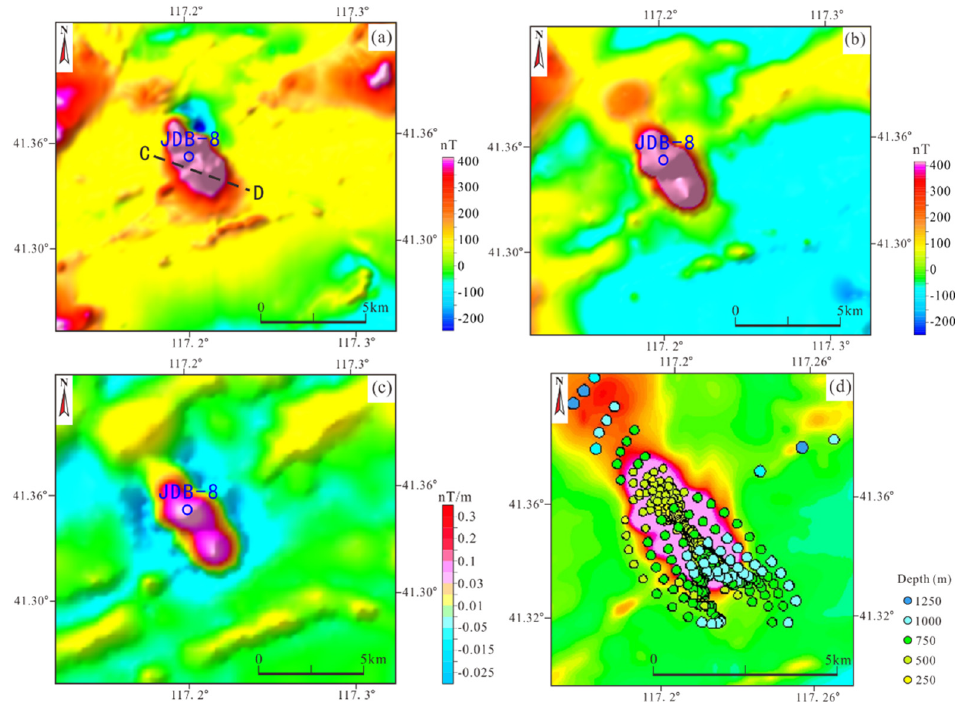
Figure 10. Aeromagnetic anomaly JDB-8 and its conversion: ( a ) Aeromagnetic data ∆ T, ( b ) reduction to the pole of aeromagnetic data ∆ T, ( c ) the first vertical derivative of reduction to the pole of aeromagnetic data ∆ T, ( d ) depth by Euler deconvolution.